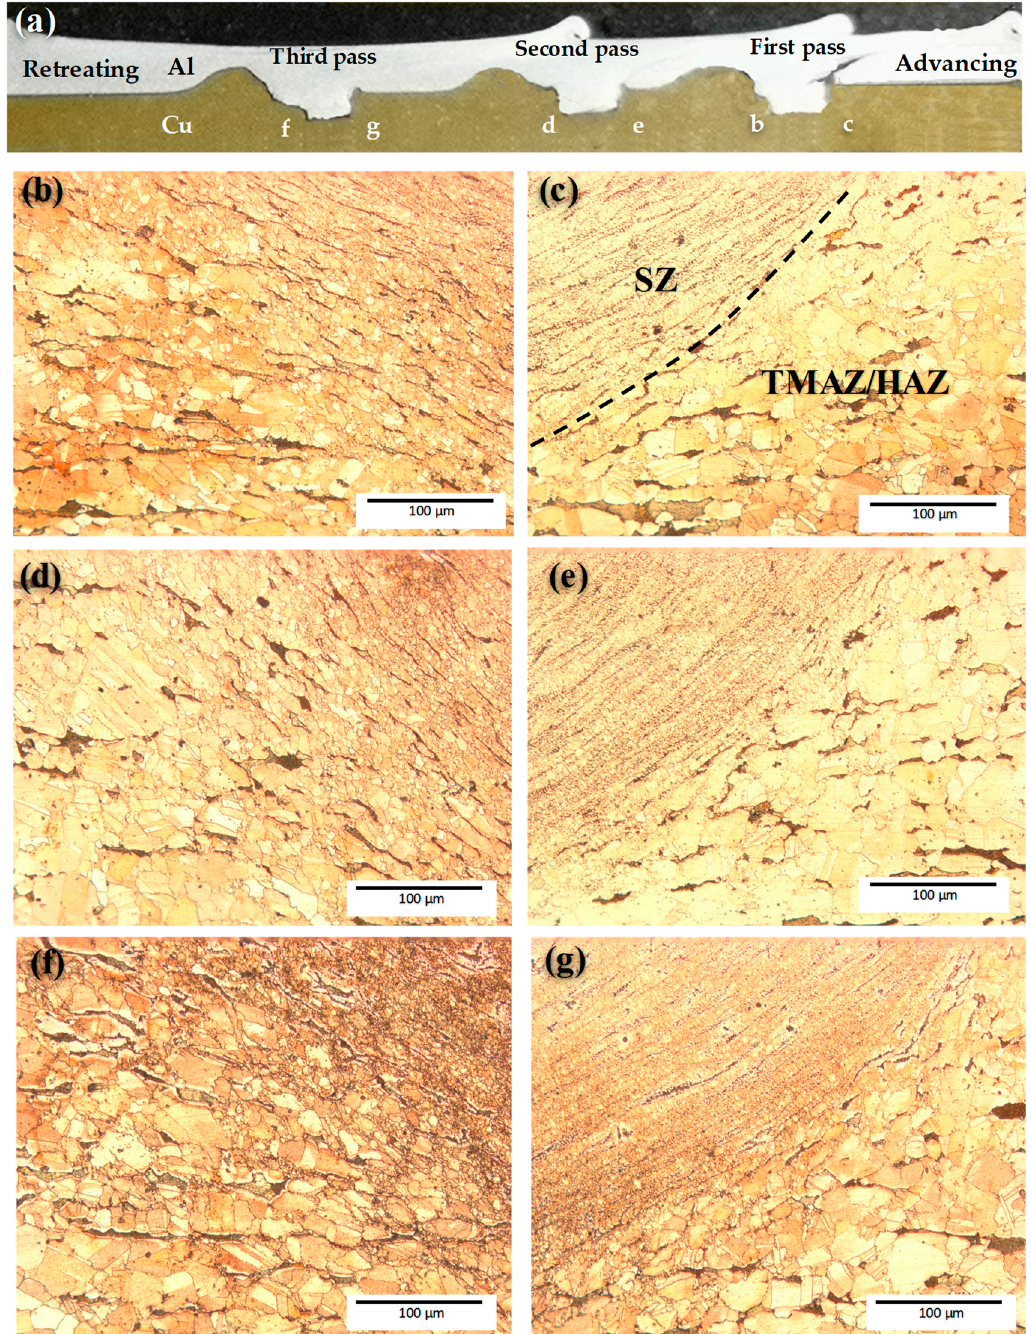
Figure 12. Microstructural morphology of Cu alloy after joining; ( a ) macrostructure of friction stir-cladded sample at the condition of 1055 r/min, 9 mm/min, and 50% overlap; ( b ), ( d ) and ( f ) thermo-mechanical affected zone/heat-affected zone (TMAZ/HAZ) of retreating side for the first, second and third passes, respectively, ( c ), ( e ) and ( g ) TMAZ/HAZ of advancing side for the first, second and third passes, respectively.